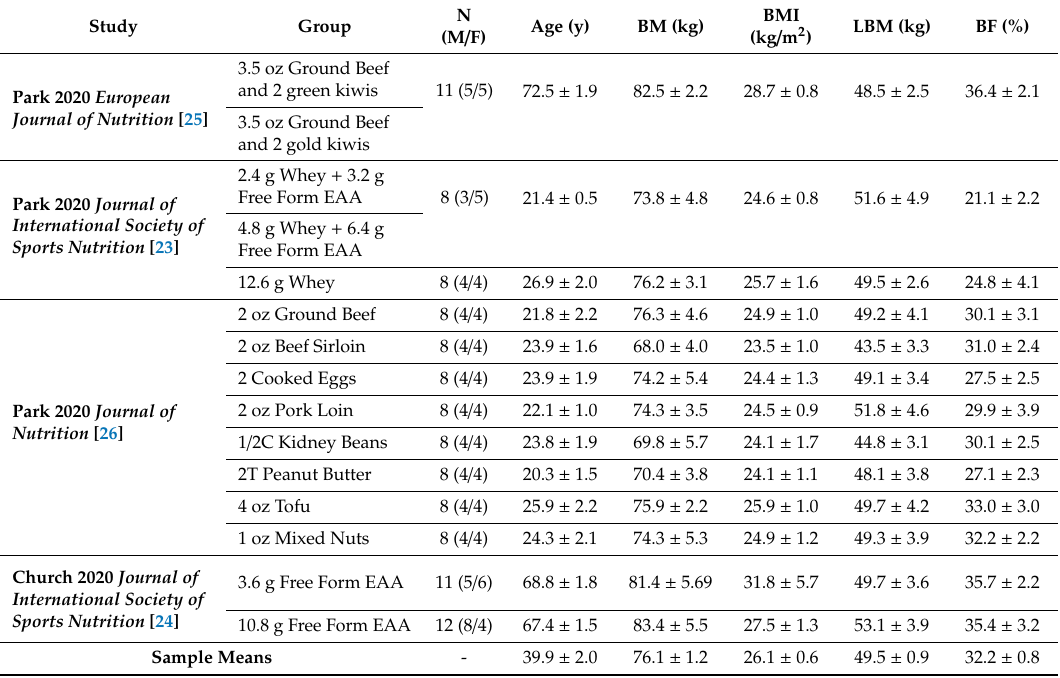
Table 1. Participant demographics from compiled studies